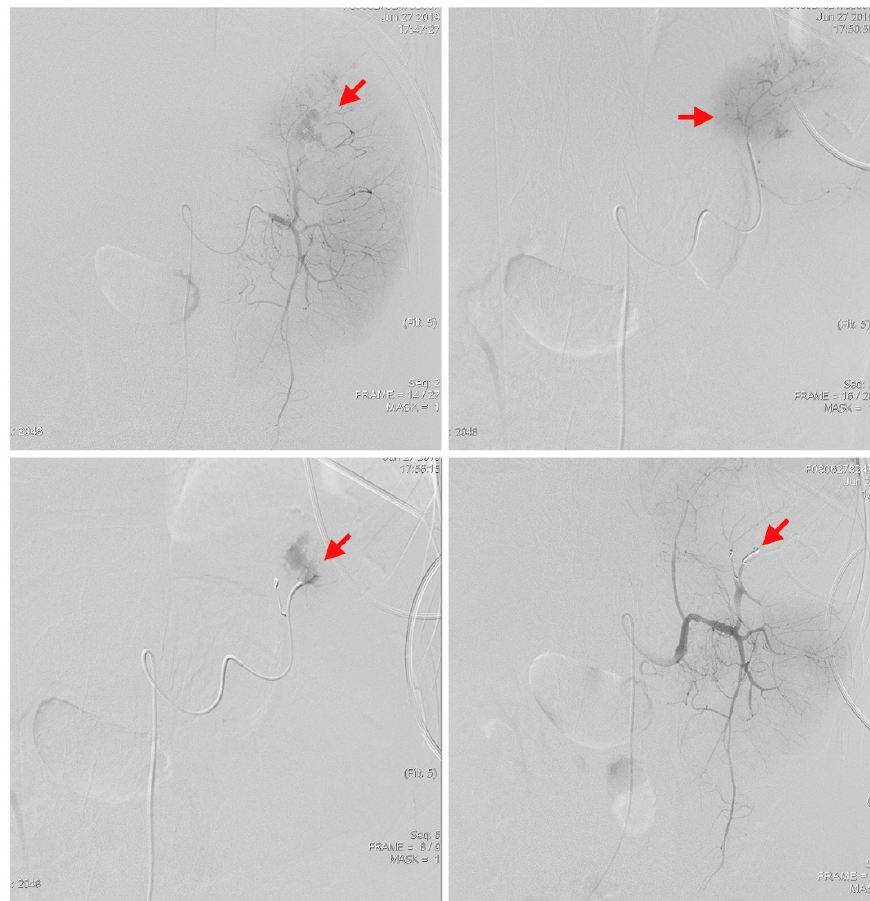
Figure 2. An emergency transcatheter arterial embolization was performed using two coils to control splenic hemorrhage (red arrows).